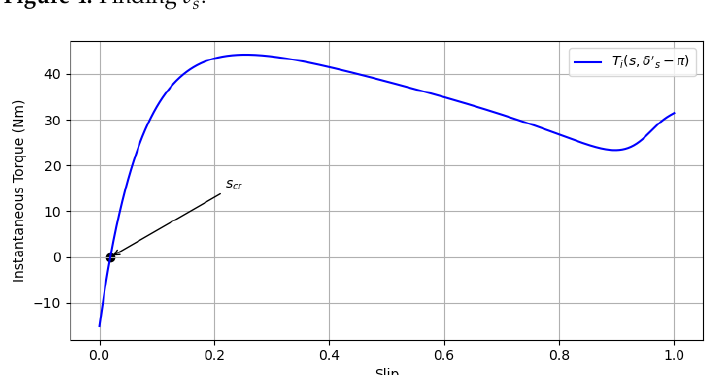
Figure 4. Finding δ (cid:48) s .